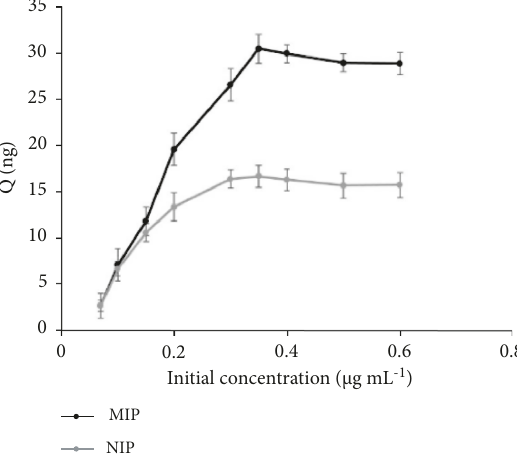
Figure 4: Extraction amounts curves for SPME-MIP and NIP fibers versus phenobarbital concentration. Extraction conditions: pH 7; desorption solvent: MeOH; extraction time: 20 minutes; desorption time: 15 minutes; stirring rate: 600 rpm.